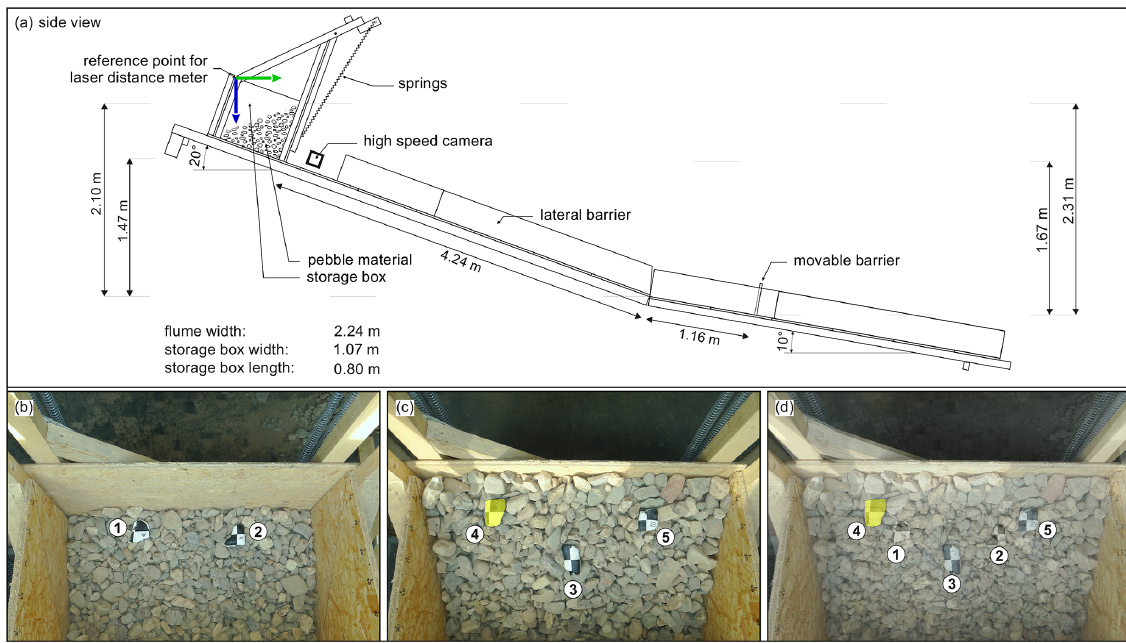
Figure 2. Experimental setup. (a) Simplified sketch of the laboratory flume. Green and blue arrows mark axes of the flume reference system in the y f and z f direction, respectively. (b–d) Starting positions of the five equipped embedded (b) and superficial (c) pebbles. (d) Overlay of (b) and (c) showing the initial positions of all equipped pebbles prior to the experiment. Pebble 4, whose data were plotted in Figs. 3 to 5, is highlighted in light yellow in (b) and (d) . Note that pebble 5 could not be included in the analyses due to its